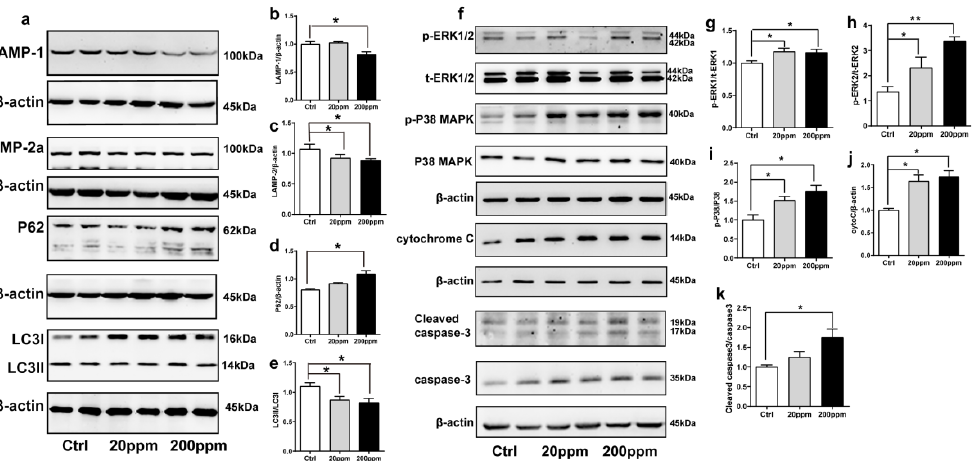
Figure 3. Effects of Zn 2+ on autophagy–lysosome and apoptosis pathways in mice. Autophagy–lysosome pathway (( a ), representative pictures; ( b – e ), quantification): the expression levels of LAMP-1 ( a , b ), LAMP-2a ( a , c ), P62 ( a , d ), LC3 I and LC3 II (( a , e ) quantification of ratio of LC3II to LC3I) were determined through Western blot analysis using β -actin as an internal control. Apoptosis pathway (( f ), representative pictures; ( g – k ), quantification): the p-ERK1 ( f , g ), p-ERK2 ( f , h ), p-p38 ( f , i ), cleaved caspase 3 ( f , k ) levels and the total protein levels of ERK1/2, p38, caspase 3 and expression levels of cytochrome C ( f , j ) were determined using Western blotting with β -actin as an internal control. Data are represented as the means ± SEM of at least three independent experiments ( n = 6). * p < 0.05, ** p < 0.01 with respect to the control group.